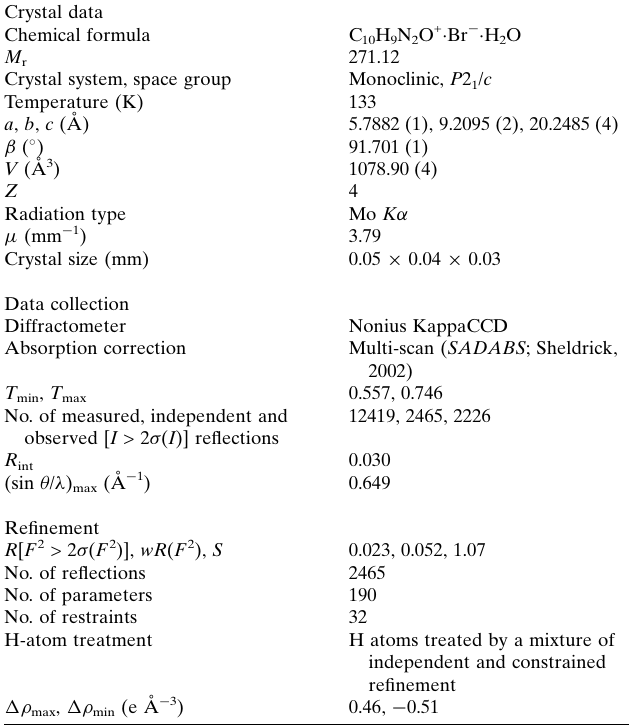
Table 2 Experimental details. Crystal data Chemical